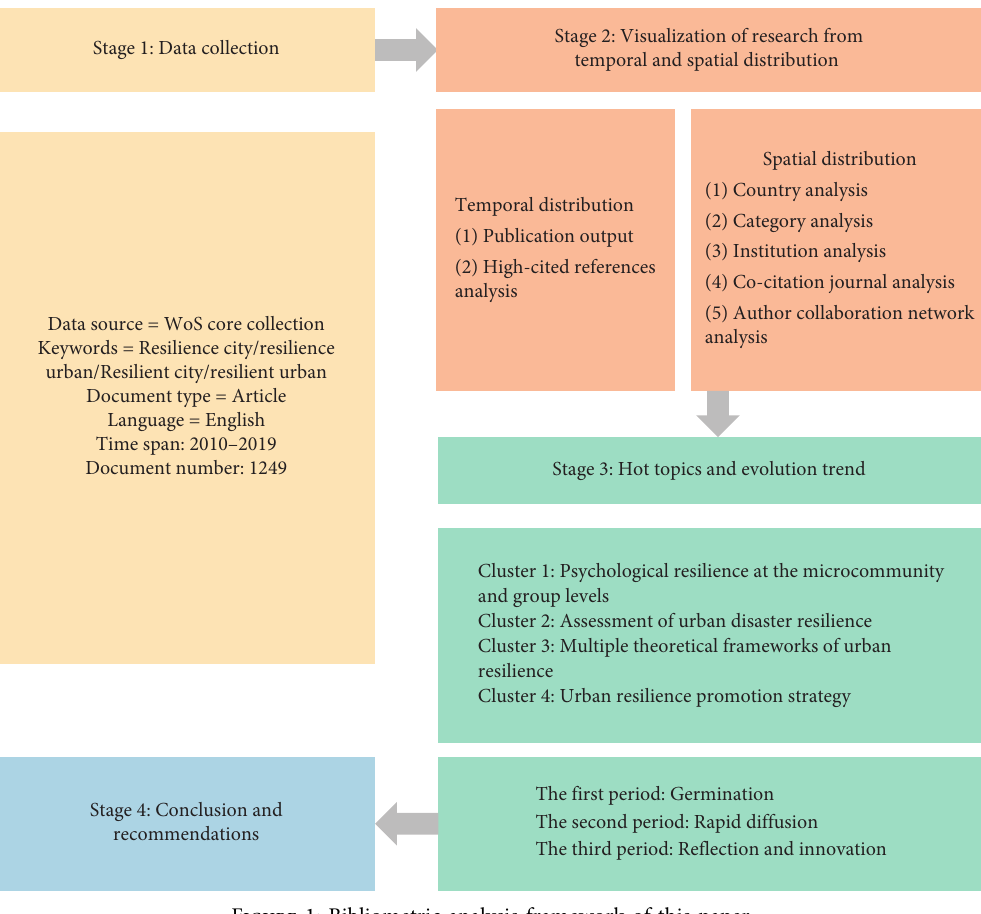
Figure 1: Bibliometric analysis framework of this paper.